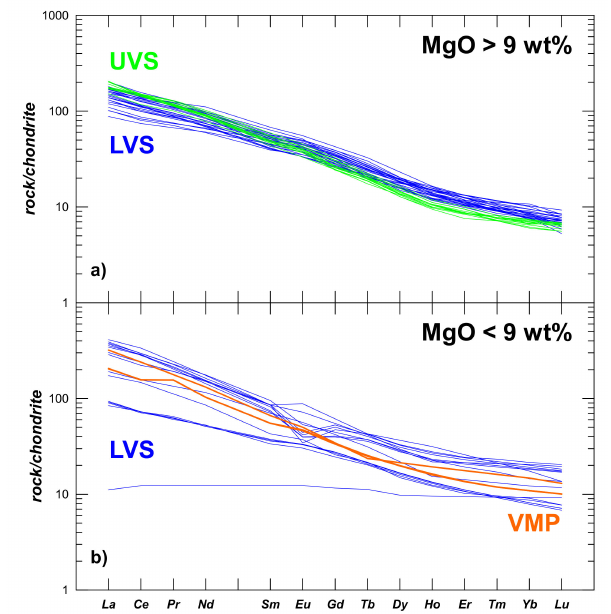
Figure 7. Chondrite normalized REE patterns for the Christmas Island lava series. ( a ) Lava with MgO contents >9 wt% MgO and in ( b ) lava with <9 wt% MgO, also plotted in ( b ) are the lava from the VMP dredged by the RV Franklin during voyage FR9_87.